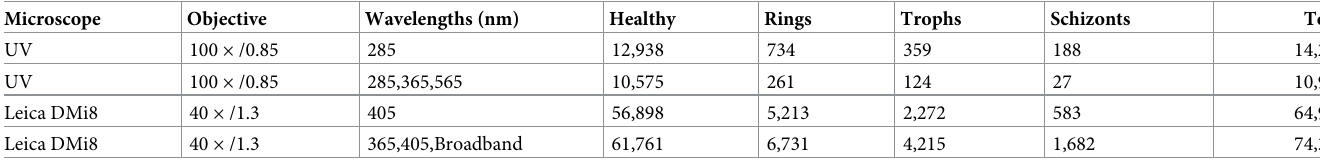
Table 1. Summary of training and validation datasets.